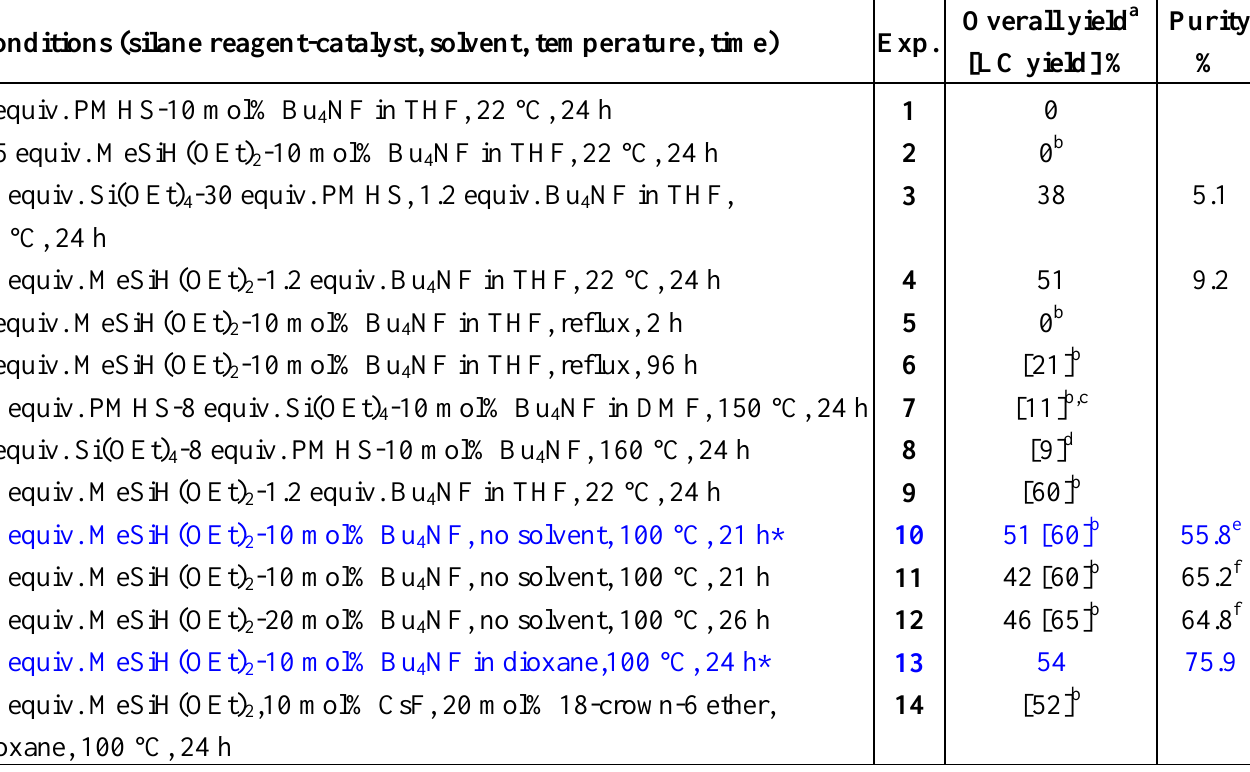
Table 1: Reduction of 5-hydroxy-6-methyl-pyridine-3,4-dicarboxylic acid diethyl ester ( 5 ).